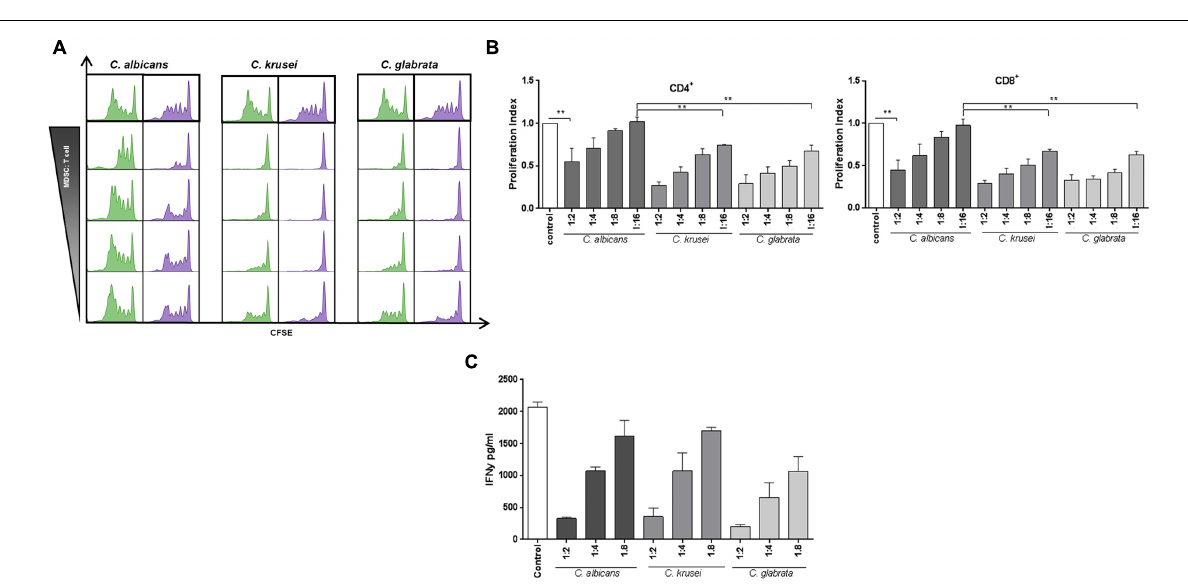
FIGURE 2 | Candida -induced MDSCs suppress T cell responses. MDSCs generated by Candida species are able to suppress T-cell proliferation and function in a dose dependent manner. The suppressive effects of CD33 + -MACS-isolated MDSCs on CD4 + (green) and CD8 + (lilac) were assessed by T-cell proliferation (CFSE polyclonal proliferation) assay. MDSCs were generated by incubating PBMCs (5 × 10 5 /ml) from healthy donors with heat killed yeast cells of various Candida species (1 × 10 5 /ml) or C. albicans yeasts for 6 days. (A) Representative CFSE stainings, showing the effect of in vitro C. albicans, C. krusei , and C. glabrata induced MDSCs on CD4 + and CD8 + T-cell proliferation. Different MDSC to T cell ratios were assessed by using a wide range of MDSC:Target ratio (1:2, 1:4, 1:6, 1:8, and 1:16). (B) The bar graphs represent the proliferation index compared to control conditions. Even at a higher MDSC:target ratio of 1:16, MDSCs induced by C. krusei , and C. glabrata show higher suppressive activity in comparison to C. albicans . Data is shown as mean ± SEM ( n = 4) ∗∗ P < 0.01. (C) IFN γ secretion of T cells is decreased by MDSCs. IFN γ secretion in the supernatant was measured on day 4 of MDSC/T cell co-culture experiments by ELISA. The concentration is given in pg/ml ( n =